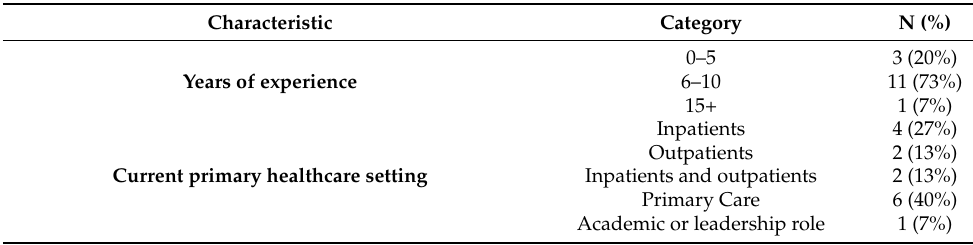
Table 1. Participant